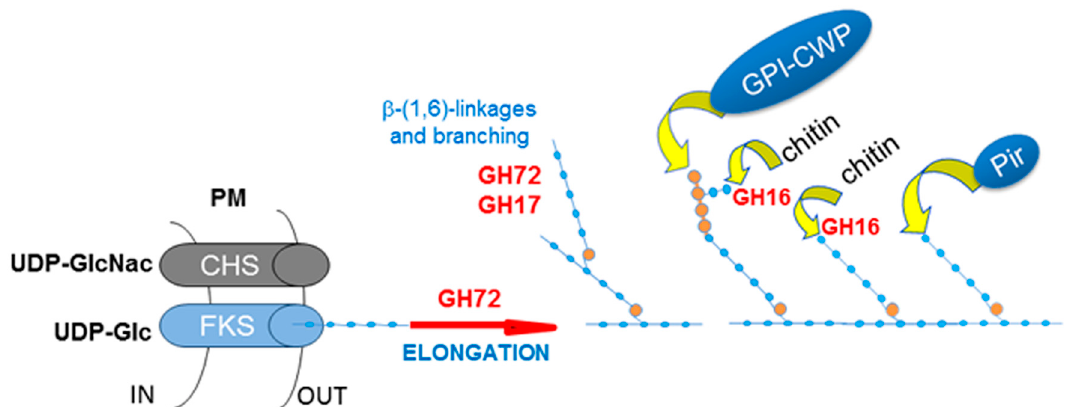
Figure 5. Scheme for the assembly of cell wall components in the extracellular space. In red are indicated the family of transglycosylases described in the text; in light blue: β -(1,3)-glucan; in orange β -(1,6)-glucose-linked residues. GH72 and GH17 cooperate in creating the core glucan structure and the anchoring sites for the other cell wall components. Pir are proteins with internal repeats that are directly linked to β -(1,3)-glucan chains through alkali labile ester linkages [52].